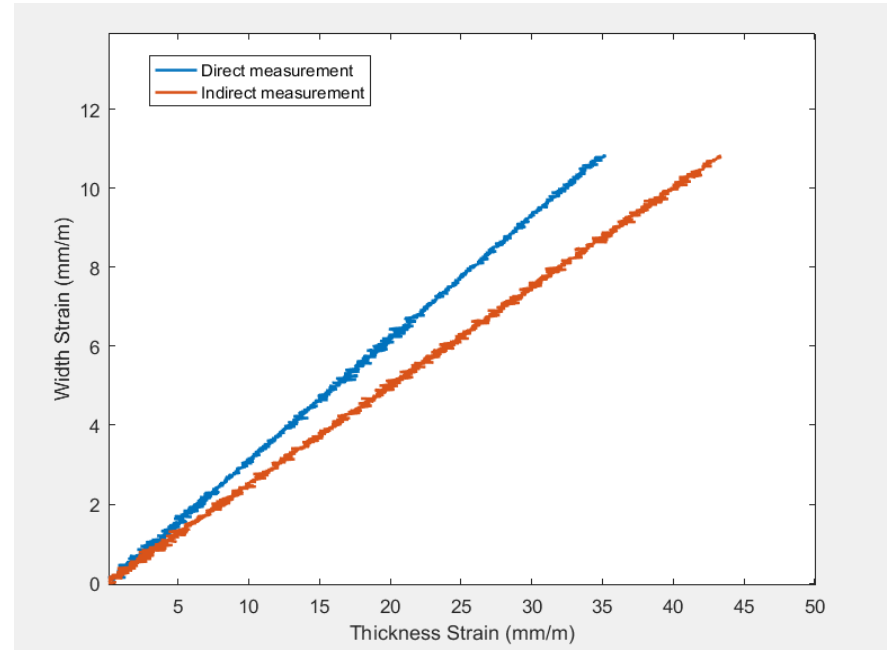
Figure 18. R-value curves of polymer.